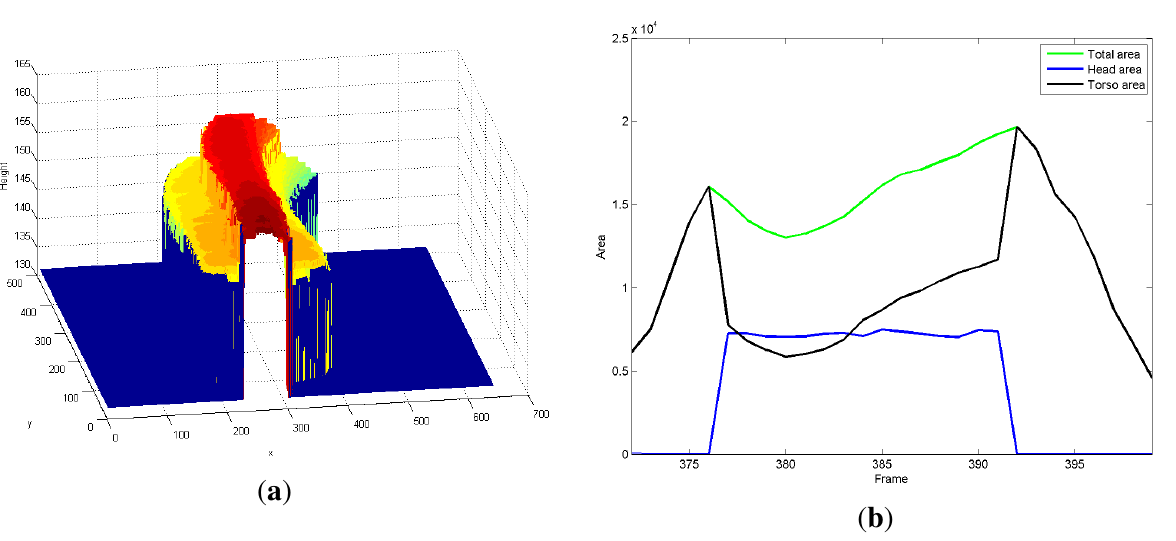
Figure 6. ( a ) 3D trajectory virtual volume; ( b ) area (blob and sub-blobs) related features (in pixels) extracted during a blob tracked trajectory (frames